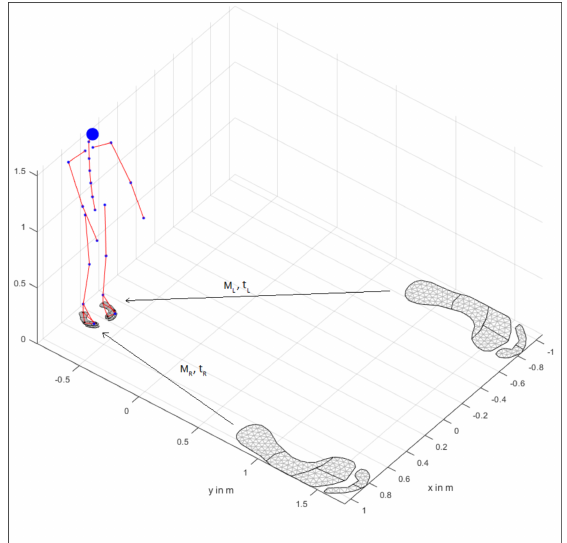
Figure 2. Standard foot model registered via right ( M R , t R ) and left ( M L , t L ) transformation using the anatomic landmarks from both the model and the